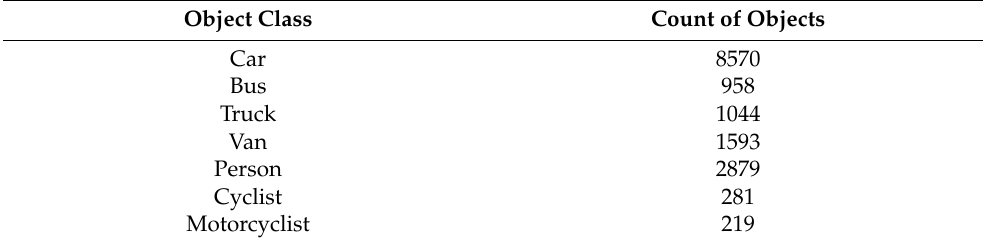
Figure 12. Comparison of mAP metric for different object detection models by minimum label size in pixels (horizontal axis) and label class (chart—vehicles top, people below), where the filter pixel size is zero. All labeled objects are considered. Table 5. Number of objects of different categories collected in the evaluation